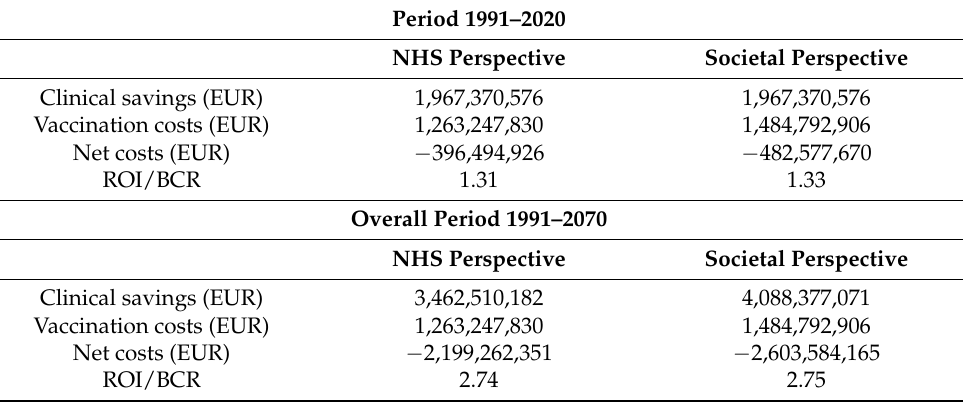
Table 5. Costs/Savings (in EUR) and ROI/BCR during the first 30 years of the vaccination